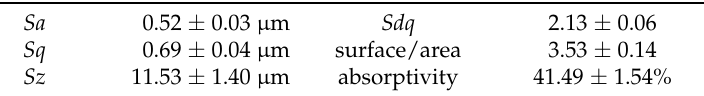
Table 1. The mean values of initial state specimens.